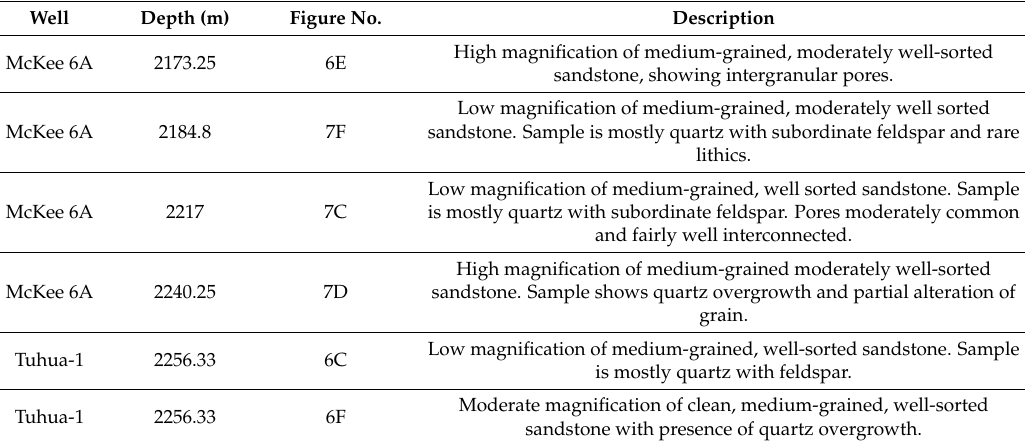
Figure No. Description High magnification of medium-grained, moderately well-sorted sandstone, showing intergranular pores. Low magnification of medium-grained, moderately well sorted 7F sandstone. Sample is mostly quartz with subordinate feldspar and rare lithics. Low magnification of medium-grained, well sorted sandstone. Sample 7C is mostly quartz with subordinate feldspar. Pores moderately common and fairly well interconnected. High magnification of medium-grained moderately well-sorted sandstone. Sample shows quartz overgrowth and partial alteration of